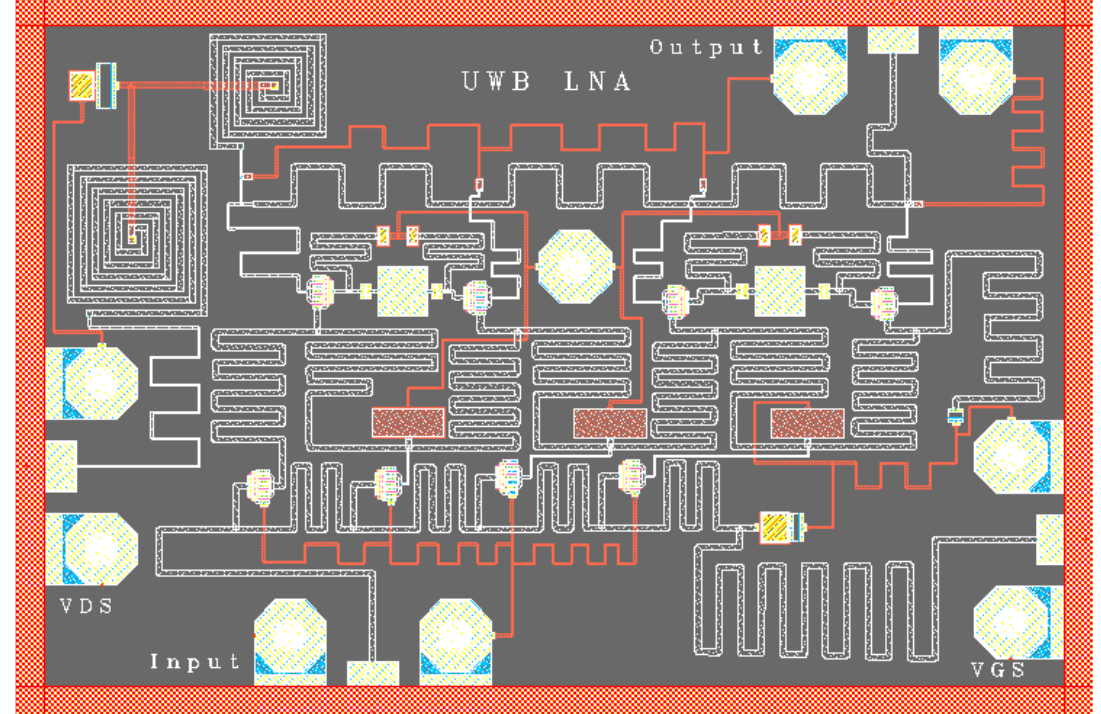
Figure 4. Photograph of the Monolithic Microwave Integrated Circuit (MMIC) Low Noise Amplifier (1.8 × 1.2 mm 2 ).